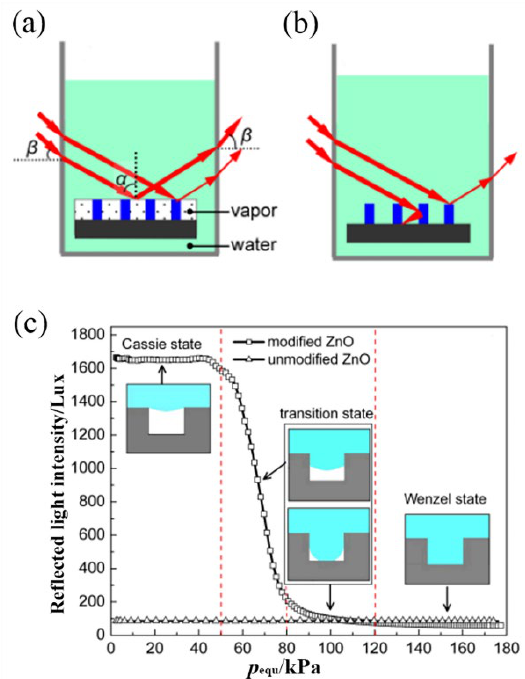
Figure 9. Schematic illustration for the optical reflection methodology: ( a ) the reflection characteristic of Cassie state, ( b ) the reflection characteristic of Wenzel state, and ( c ) the intensity of reflection light vs. equivalent pressure. Reprinted with permission from Ref. [8]. Copyright@2013, Acta Phys. -Chim. Sin.